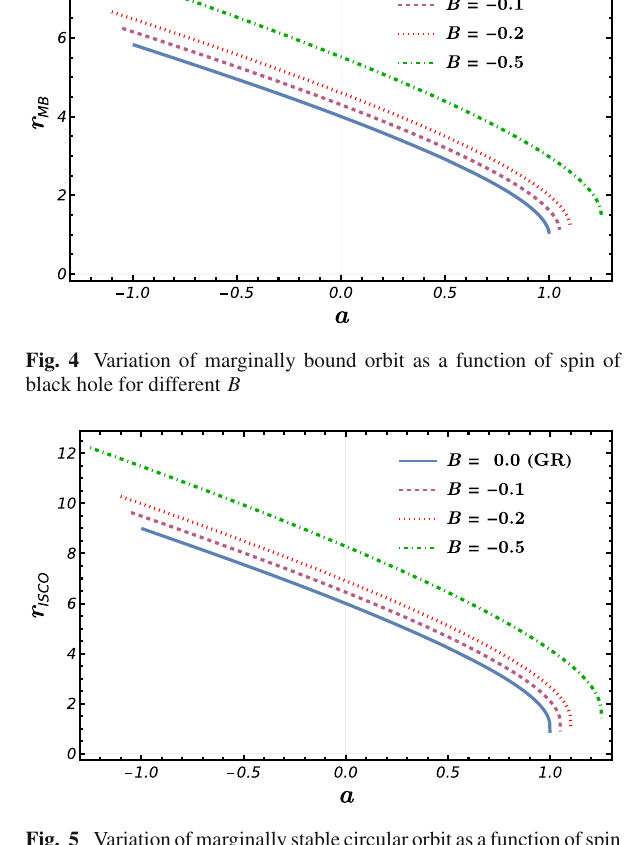
Fig. 5 Variationofmarginallystablecircularorbitasafunctionofspin of black hole for different